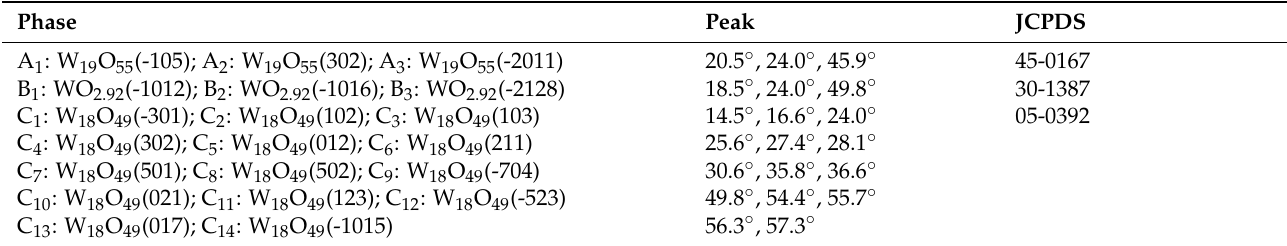
Table 2. Phases responding to the XRD peaks in Figure 1a,b.